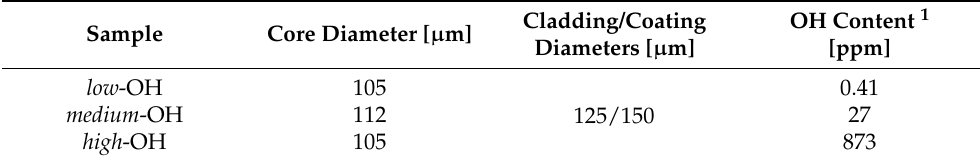
Figure 1. Spectral losses of the three multimode optical fibers under test. Table 1. Main characteristics of the three fibers under